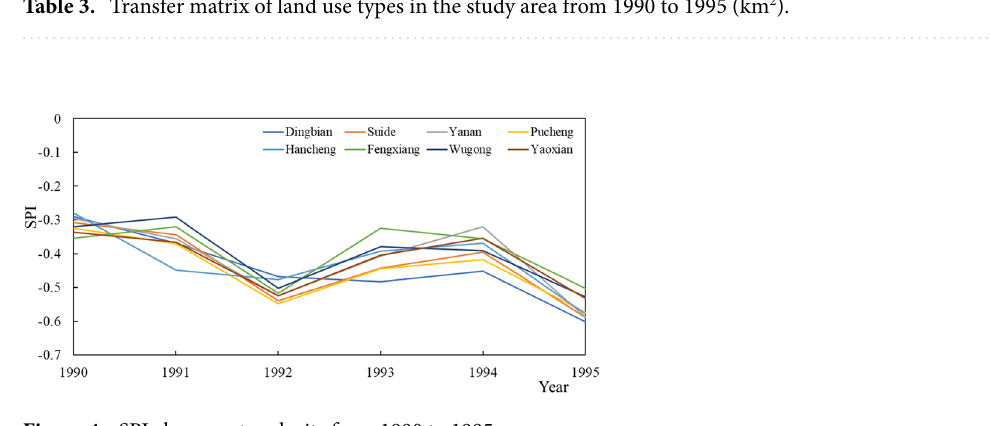
Table 3. Transfer matrix of land use types in the study area from 1990 to 1995 (km 2 ).